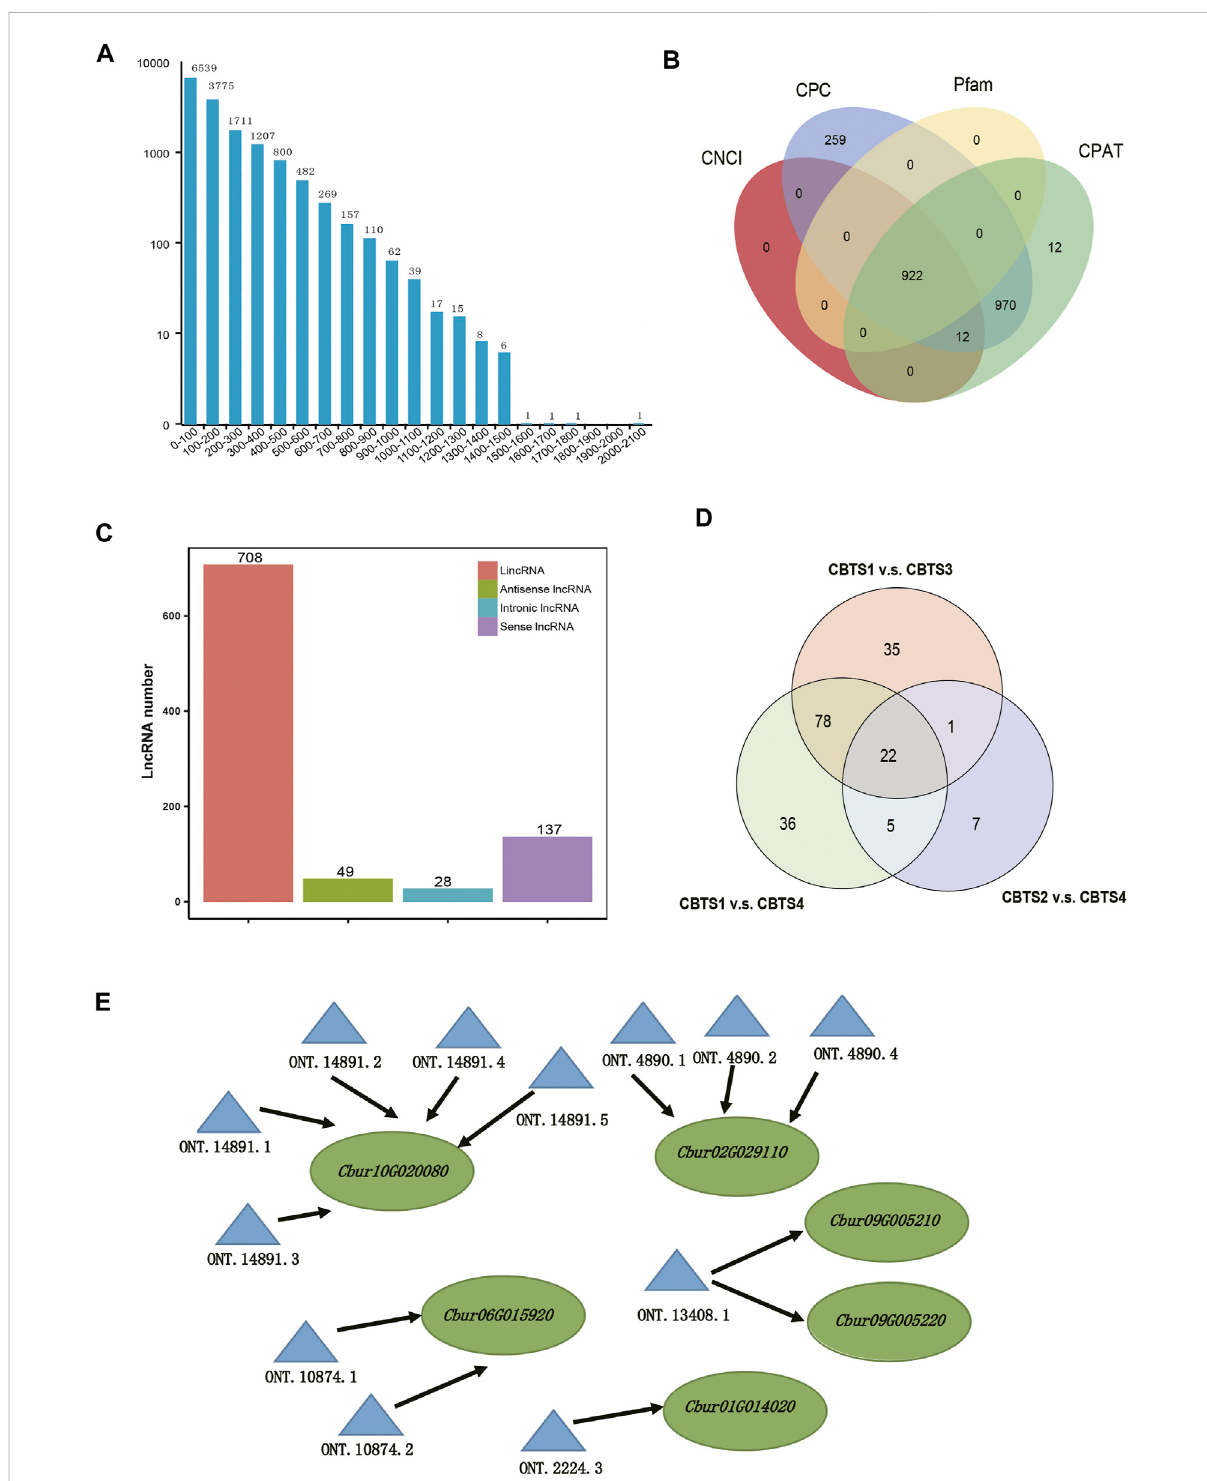
FIGURE 5 Analysis of the open reading frames (ORFs) and identi fi cation of lncRNAs based on 12 full-length transcriptomes of Cinnamomum burmannii . (A) Length distribution of ORFs detected in the full-length transcripts. (B) Venn diagram shows the number of lncRNAs fi ltered and identi fi ed using CNCI, CPC, CPAT, and Pfam. (C) Venn diagram shows the overlap in differentially expressed lncRNAs of C. burmannii leaves across the four developmental stages. (D) Solid lines represent the expression of TPS genes regulated in a cis- manner by the differentially expressed lncRNAs. (E) Representatives of predicted interaction networks among lncRNAs and their target genes. Solid lines represent the expression regulation by the lncRNAs in